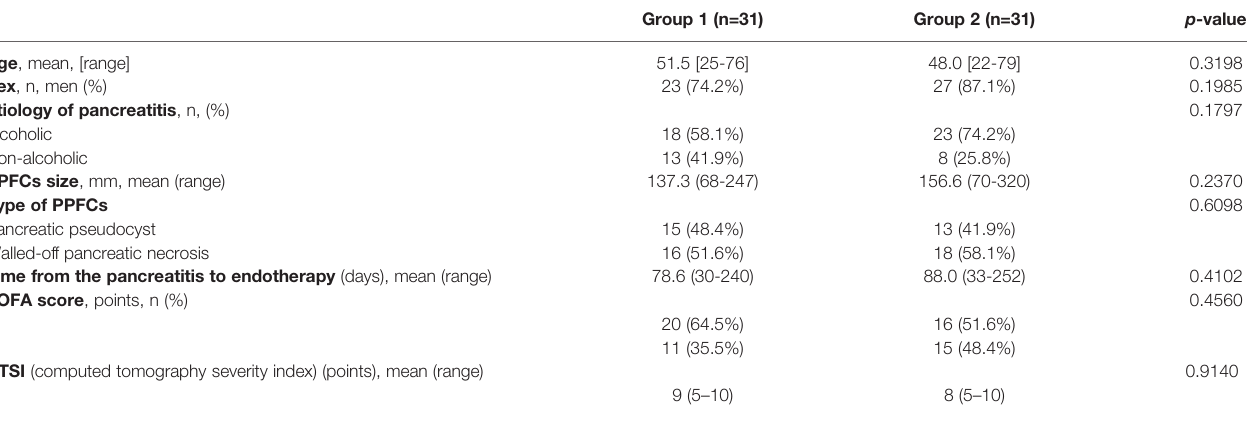
TABLE 1 | Characteristics of the patients from study